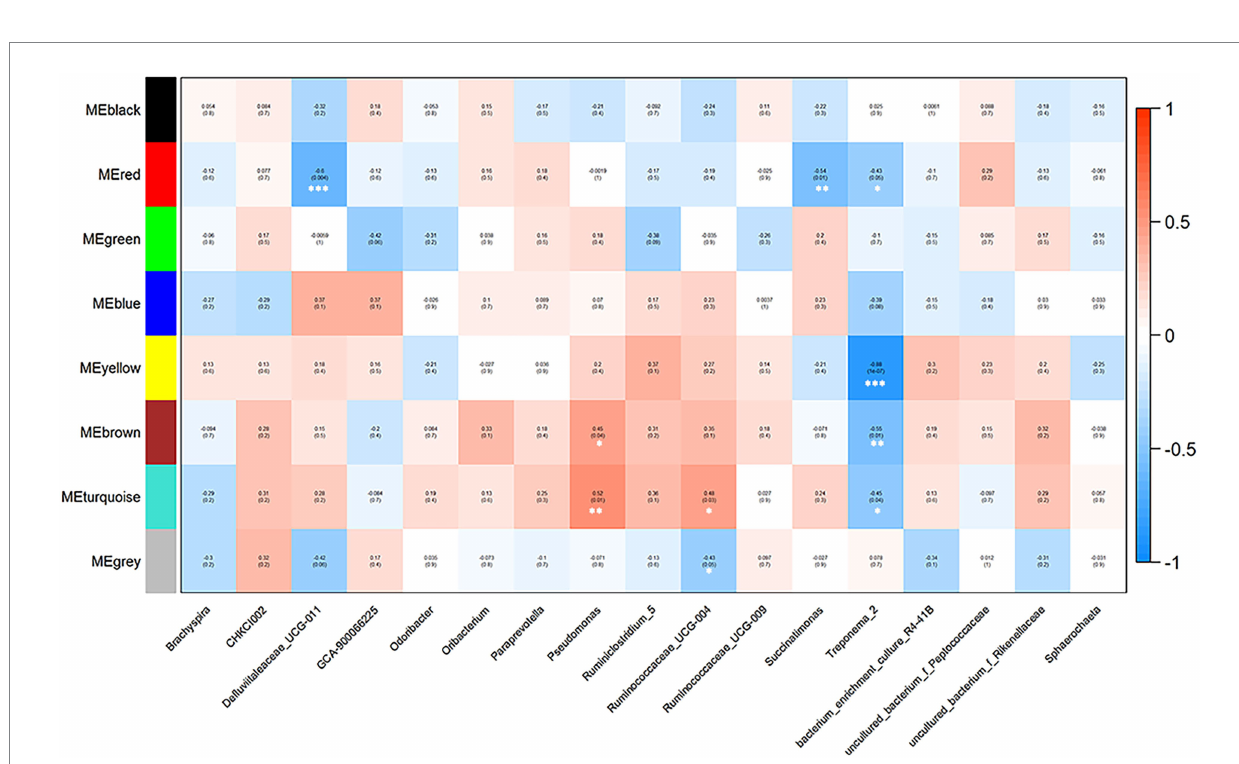
FIGURE 6 Correlations between metabolite modules and weight-related bacteria in Qiandongnan Xiaoxiang chickens at 160 ± 3 days of age ( n = 21). Each box of the matrix indicates the correlation between one metabolite module and a weight-related bacterial taxon at the genus level. The correlation coefficients ( r ) and p -value are listed in the small boxes (* p < 0.05, ** p < 0.01, *** p < 0.001). The color gradient represents the values of correlation coefficients (red for positive and blue for negative